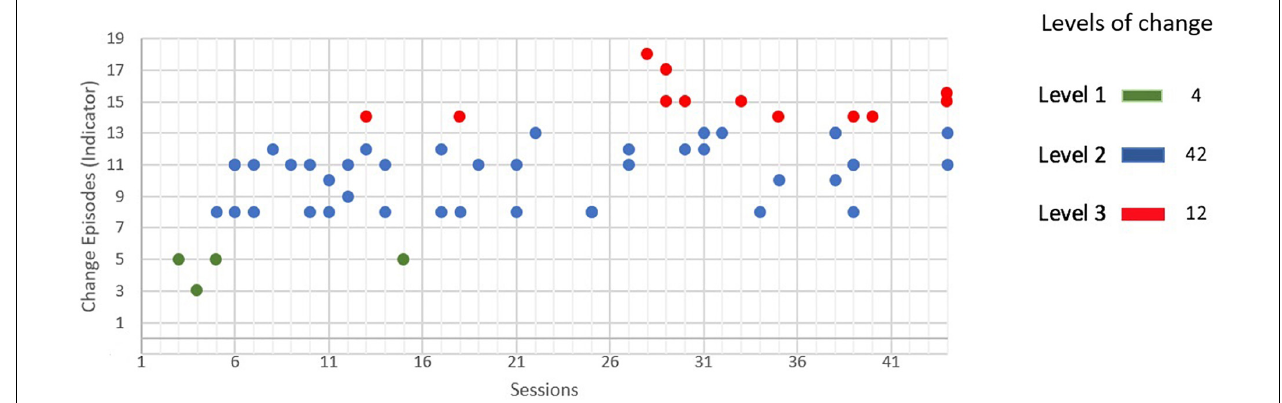
FIGURE 1 | Change episodes of the patient in the psychotherapy (44